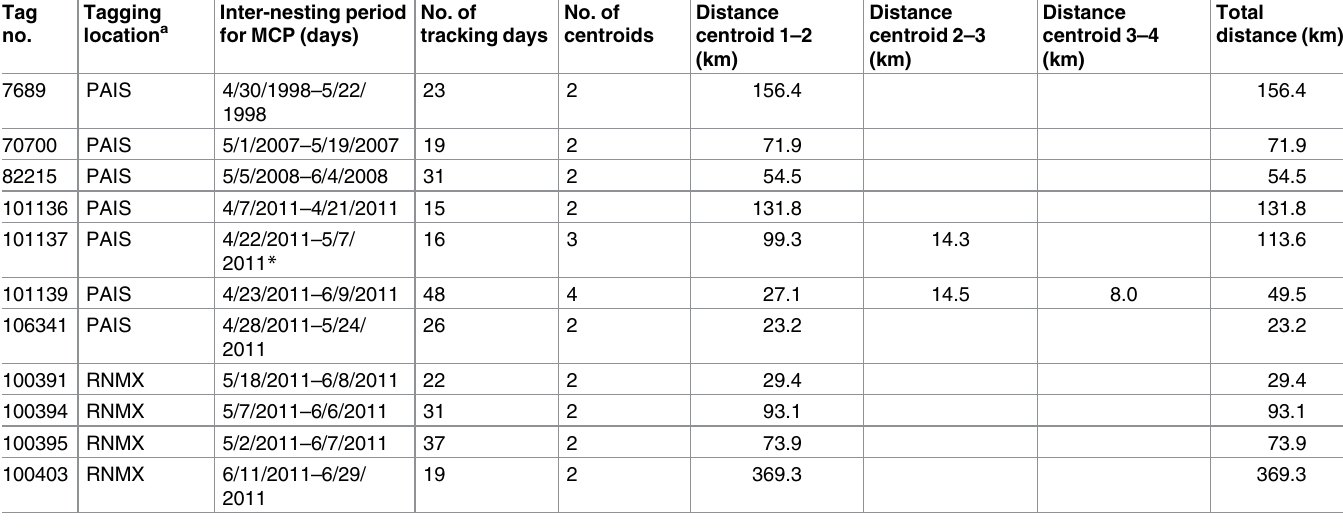
Table 2. Distancesbetween successive Minimum Convex Polygon (MCP) centroids for 11 nesting Kemp’s ridley turtles ( Lepidochelys kempii ) that had multiple centroids during the samenesting season. Tag Tagging no. location